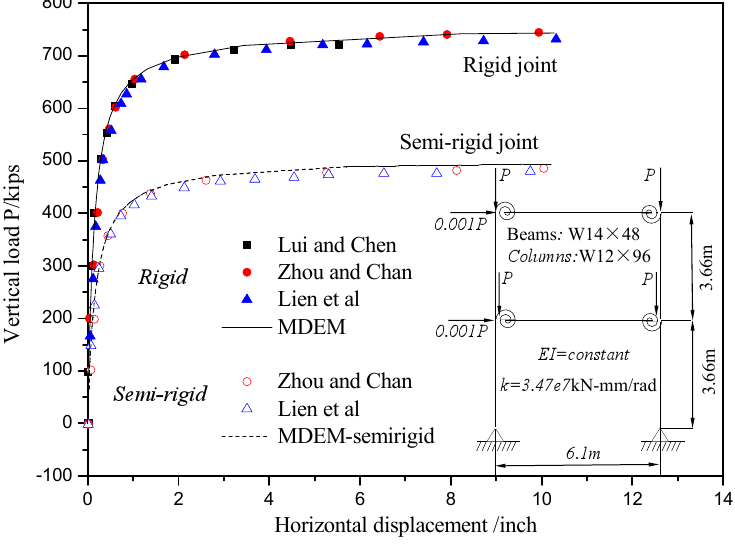
Figure 9. Horizontal displacement of steel frames with linear semi-rigid joints.